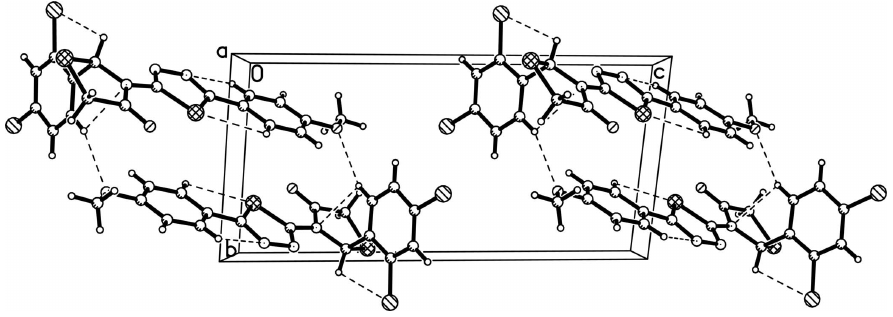
Figure 2 A partial packing diagram of (I). Hydrogen bonds are shown as dashed